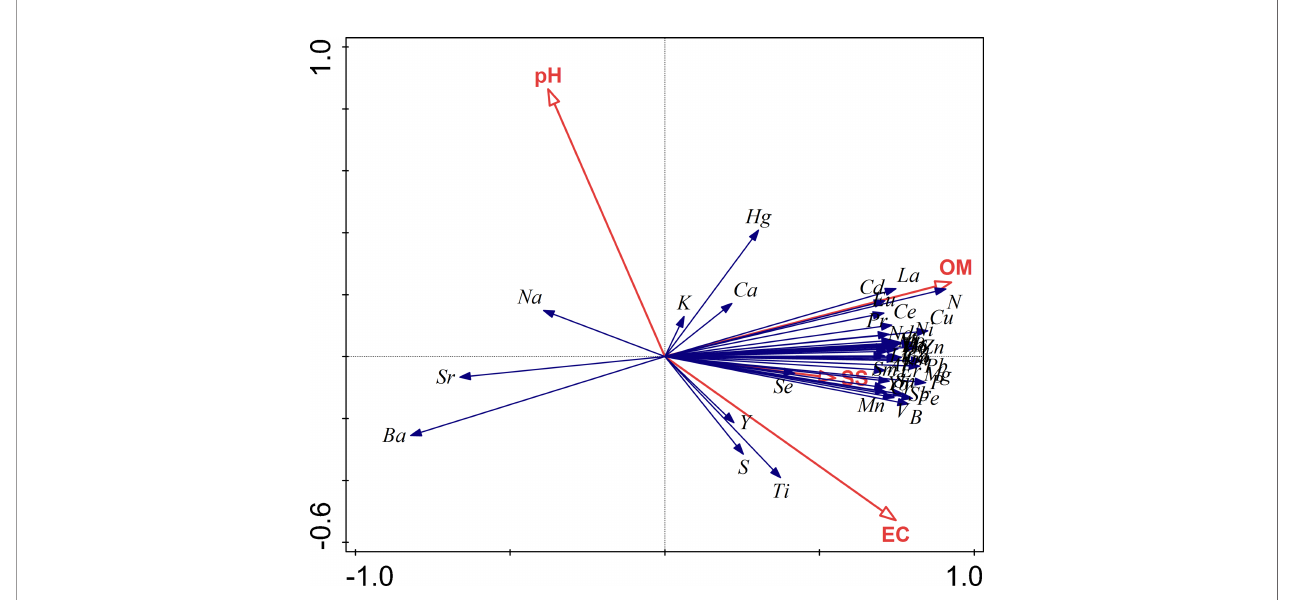
FIGURE 2 | Ordination graph of redundancy analysis of element concentrations affected by environmental factors. OM, soil organic matter content; pH; EC, electrical conductivity; and SS, soil salinity.